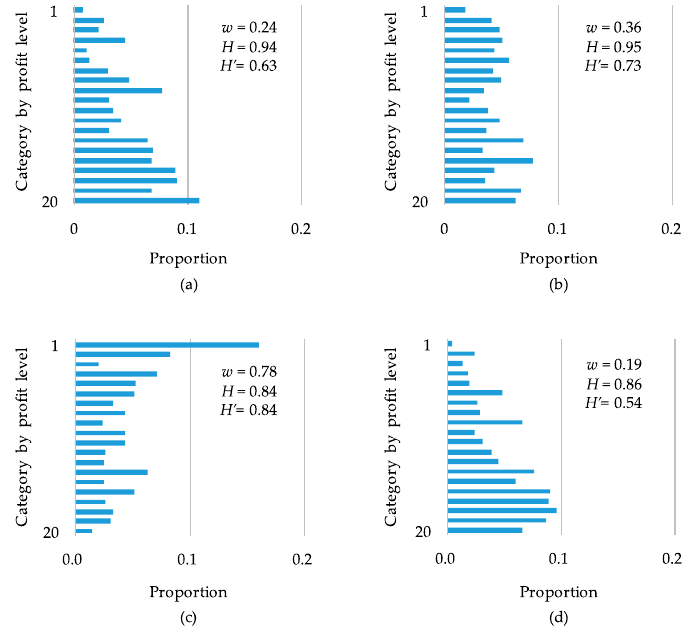
Figure 3. Distribution of regional industry with the classification by profit level: w is weight; H is entropy; and H ′ is the weighted entropy; ( a ) a moderately low-profit-industry biased region; ( b ) a moderately high-profit-industry biased region; ( c ) a high-profit-industry biased region; and ( d ) a low-profit-industry biased region.